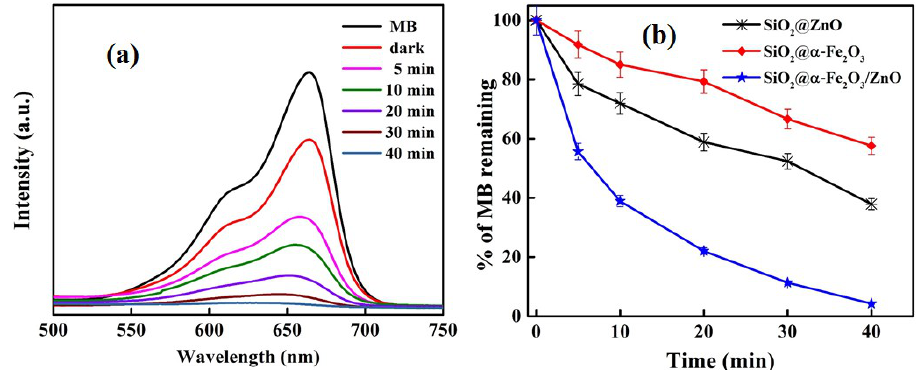
Figure 6. ( a ) Degradation of Methylene Blue MB dye (5 ppm) in the presence of SiO 2 @α-Fe 2 O 3 /ZnO nanocomposites under visible light irradiation. ( b ) The plot shows the percentage of MB remaining vs time.